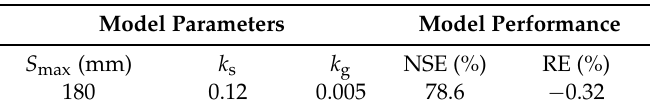
Table 1. Model parameters and model performance for discharge simulation of the Xinshui River catchment.